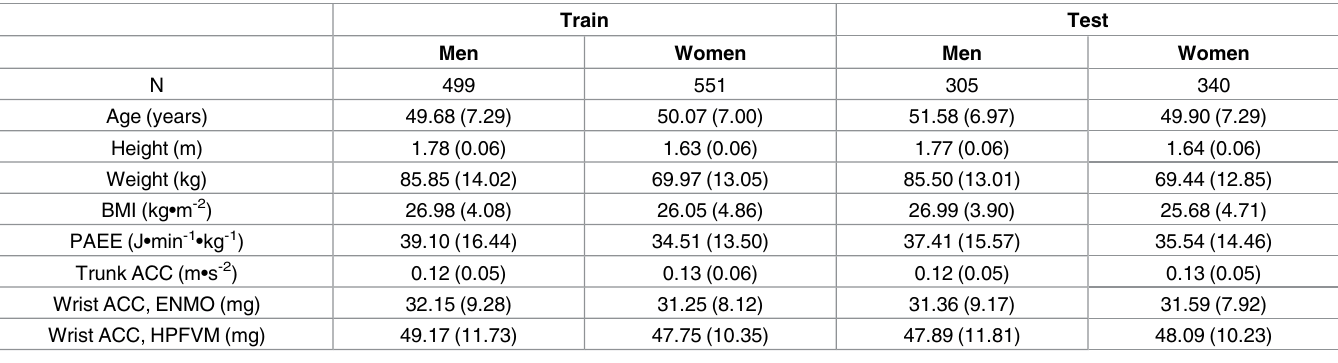
Table 1. Summarystatistics of the cohort, provided separately for the training and test datasets, by sex.